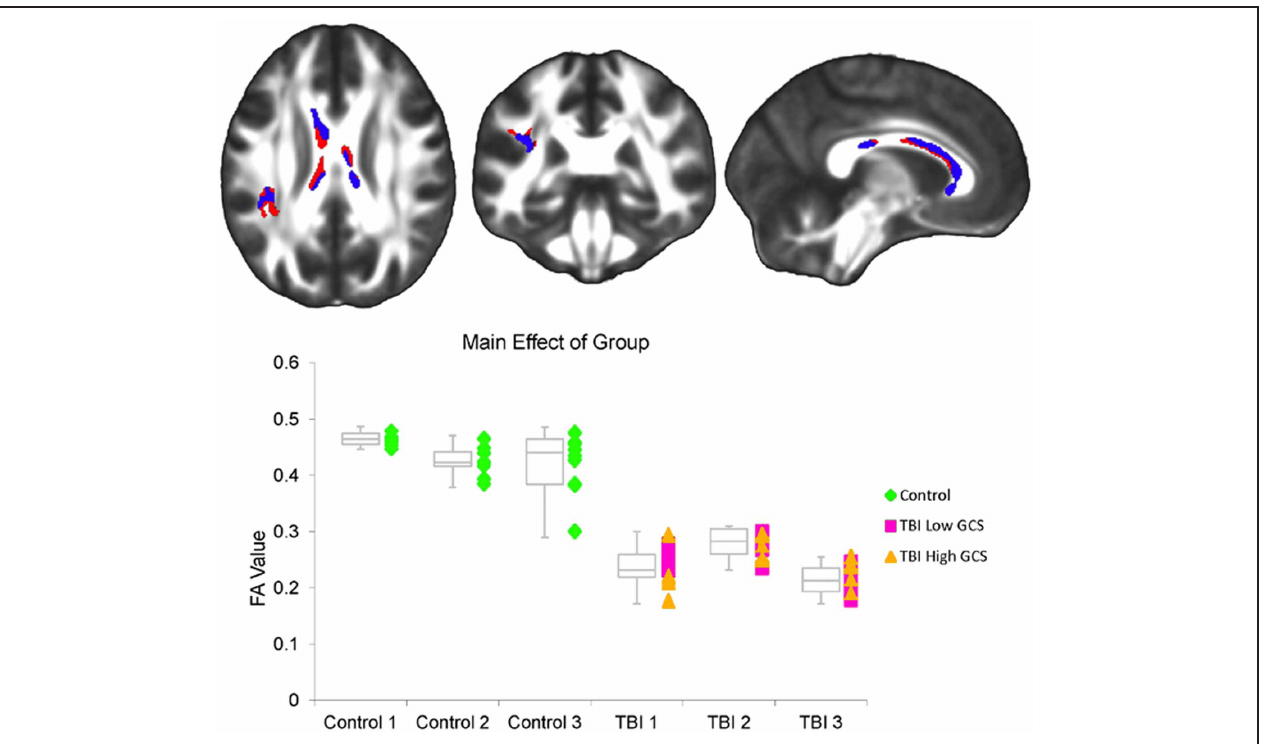
FIGURE 3 | (Top) A significant effect of time was observed throughout the corpus callosum as well as in the left SLF within the FA factorial model (red). Axial and radial diffusivity analyses were restricted to regions demonstrating an FA effect. Within this region, a significant effect of time was also observed within the radial diffusivity factorial model (overlapping blue region), but not the axial diffusivity factorial model. The left side of the statistical map is patient left and right is patient right. ( Bottom ) This graph shows the average